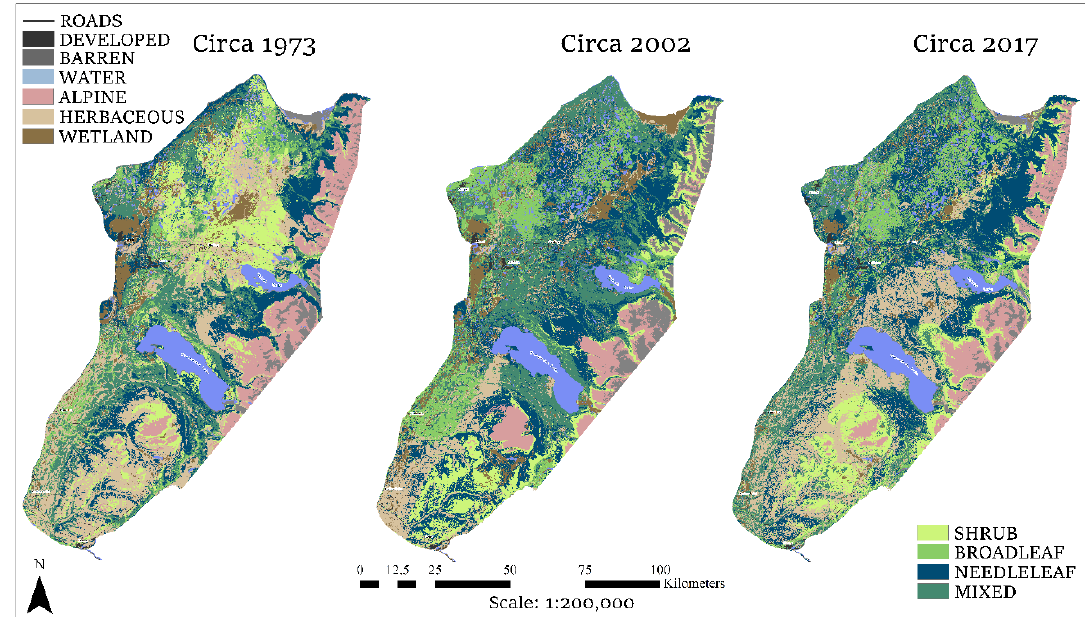
Figure 5. Spatial distribution of primary land-cover types on the Kenai Peninsula over time.